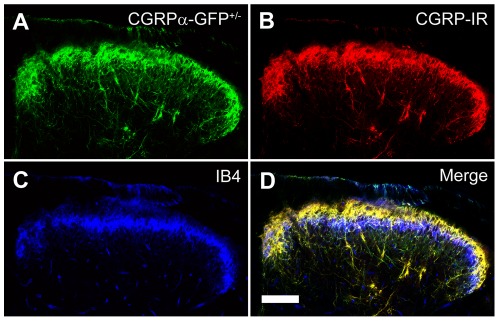
CGRPα-GFP axons terminate in dorsal spinal cord.Sections of lumbar spinal cord from CGRPα-GFP+/− mice were stained with antibodies to (A) GFP and (B) CGRP. (C) IB4-binding. (D) Merged image. Images were acquired by confocal microscopy and are representative of n = 3 mice. Scale bar in (D) is 100 µm.